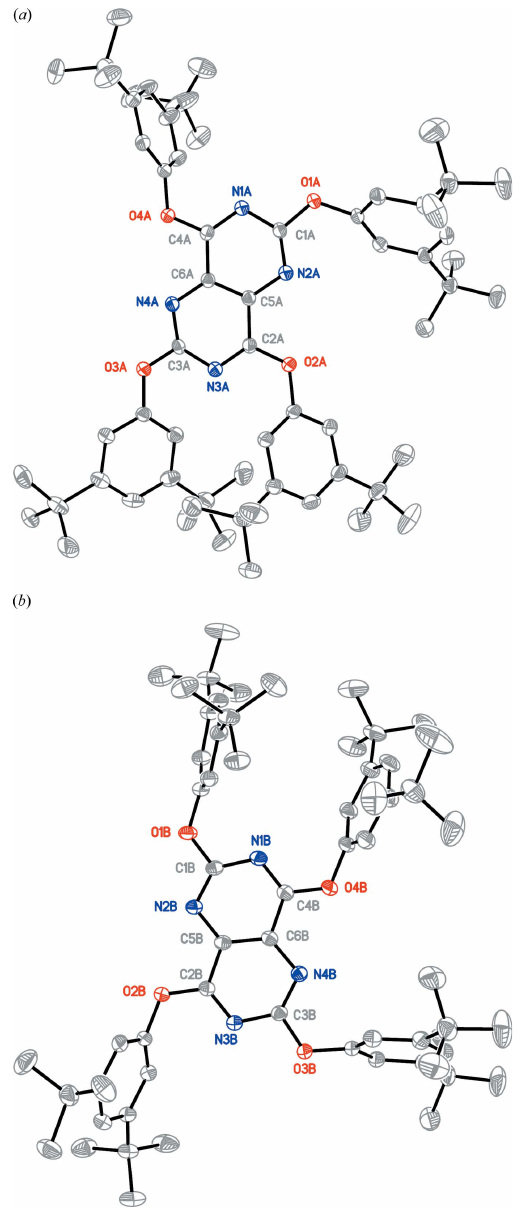
Figure 2 ( a ) View of molecule A of the asymmetric unit with the atom labelling. Displacement ellipsoids are drawn at the 50% probability level. ( b ) View of molecule B of the asymmetric unit with the atom labelling. Displacement ellipsoids are drawn at the 50% probability